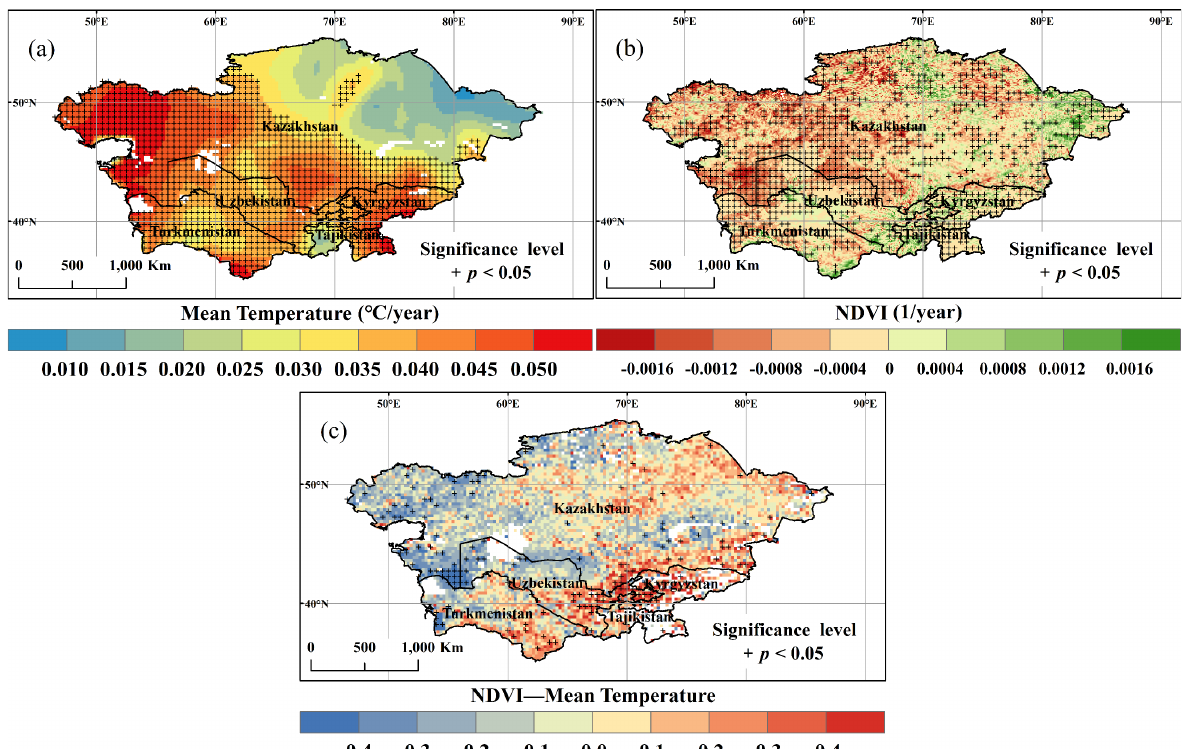
Figure 3. Spatial distribution of trends in ( a ) annual mean temperature, ( b ) annual NDVI, and ( c ) correlation between annual mean temperature and annual NDVI over the GLRCA from 1982–2014.